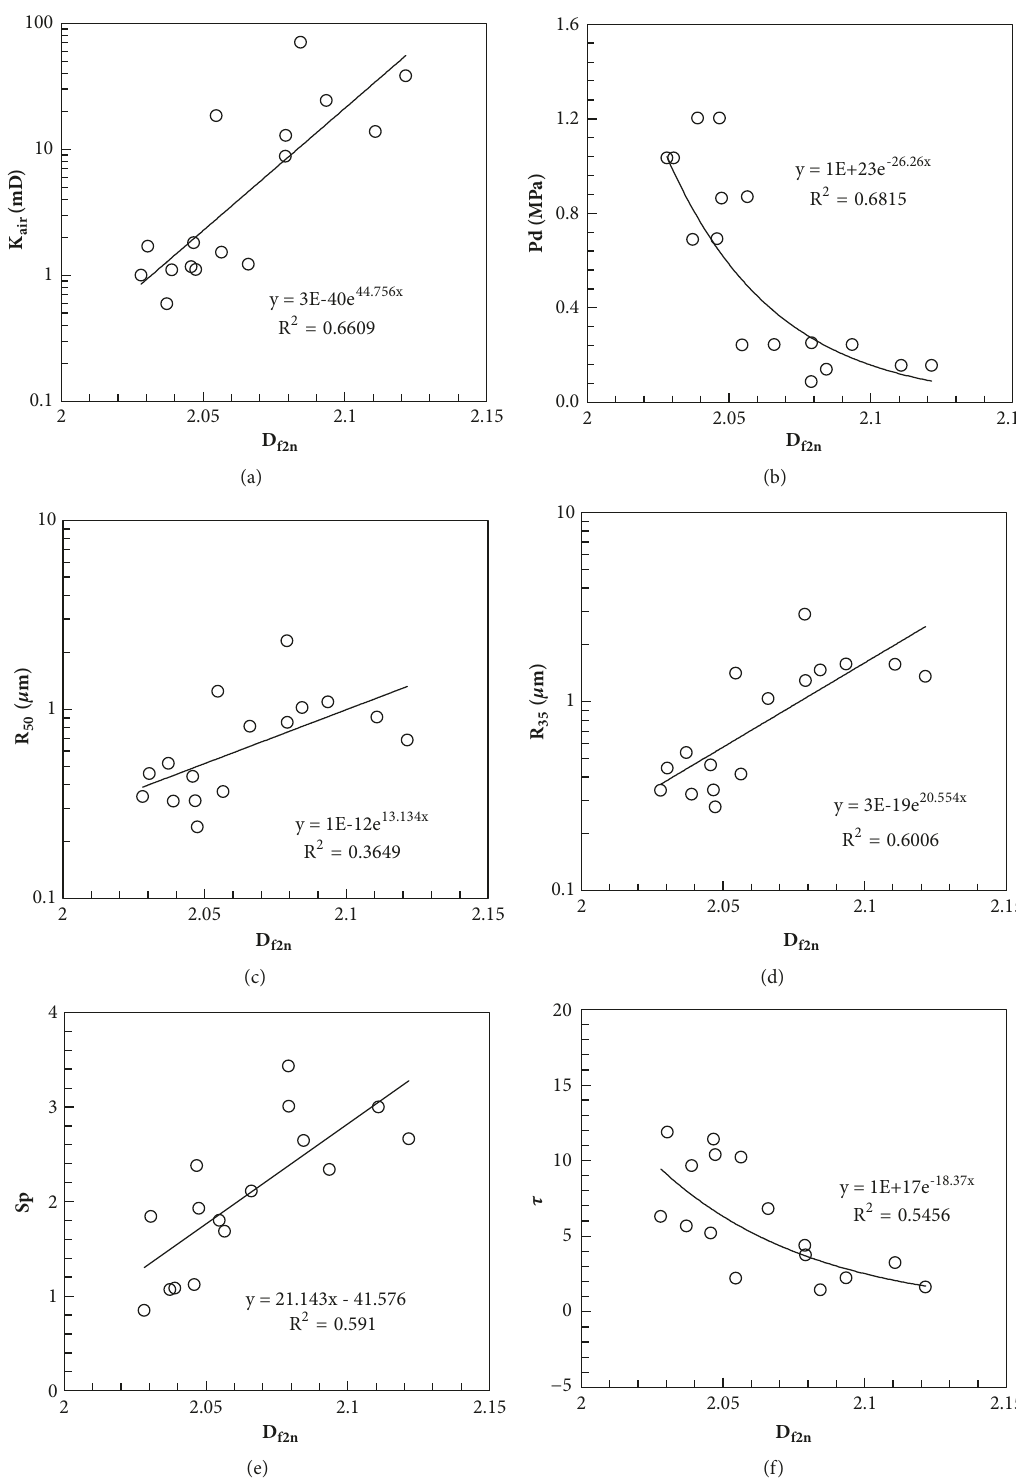
Figure 11:Relationship between fractal dimensionsof nanoscale pores 𝐷 𝑓2 n and someporestructureparameters and petrophysical properties of carbonate core samples ((a) 𝐷 𝑓2 n and air permeability 𝐾 𝑎𝑖𝑟 ; (b) 𝐷 𝑓2 n and displacement pressure 𝑝 𝑑 ; (c) 𝐷 𝑓2 n and 𝑟 50 ; (d) 𝐷 𝑓2 n and 𝑟 35 ; (e) 𝐷 𝑆 𝐷 𝜏 𝑓2 n and sorting coefficient 𝑝 ; (f) 𝑓2 n and tortuosity